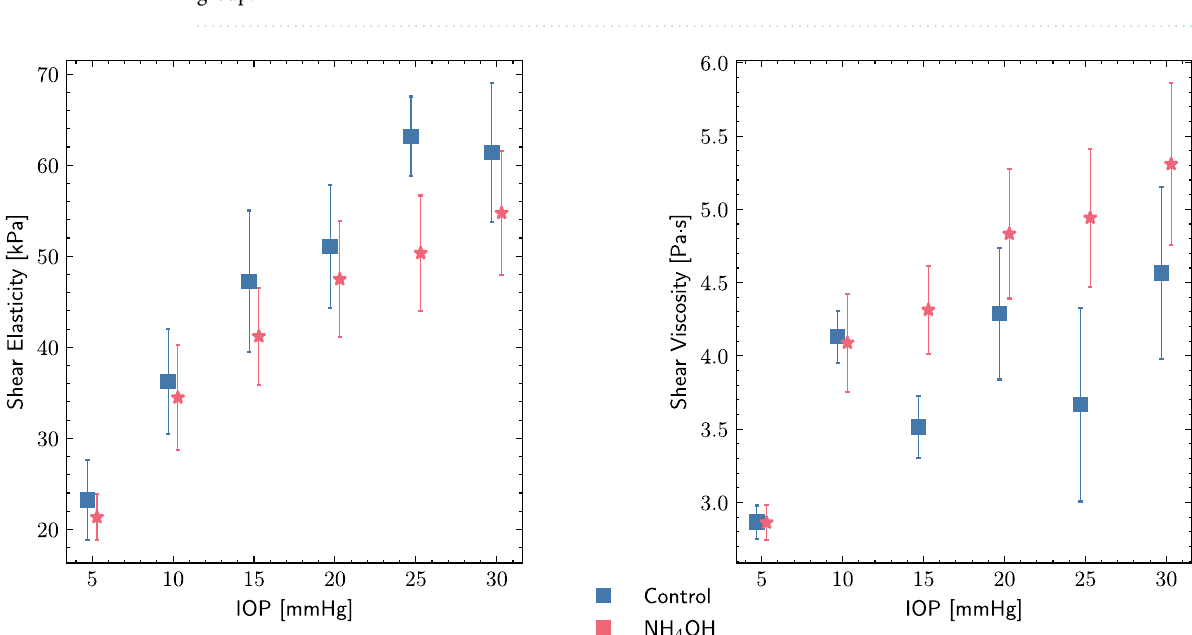
Figure 8. Viscoelastic parameters for ex vivo porcine corneal samples using Kelvin Voigt (KV) model on elastography results. Shear elasticity and viscosity are displayed for Ammonium hydroxide ( NH 4 OH) and control groups under different intraocular pressures (IOP). The results are displayed as mean ± standard